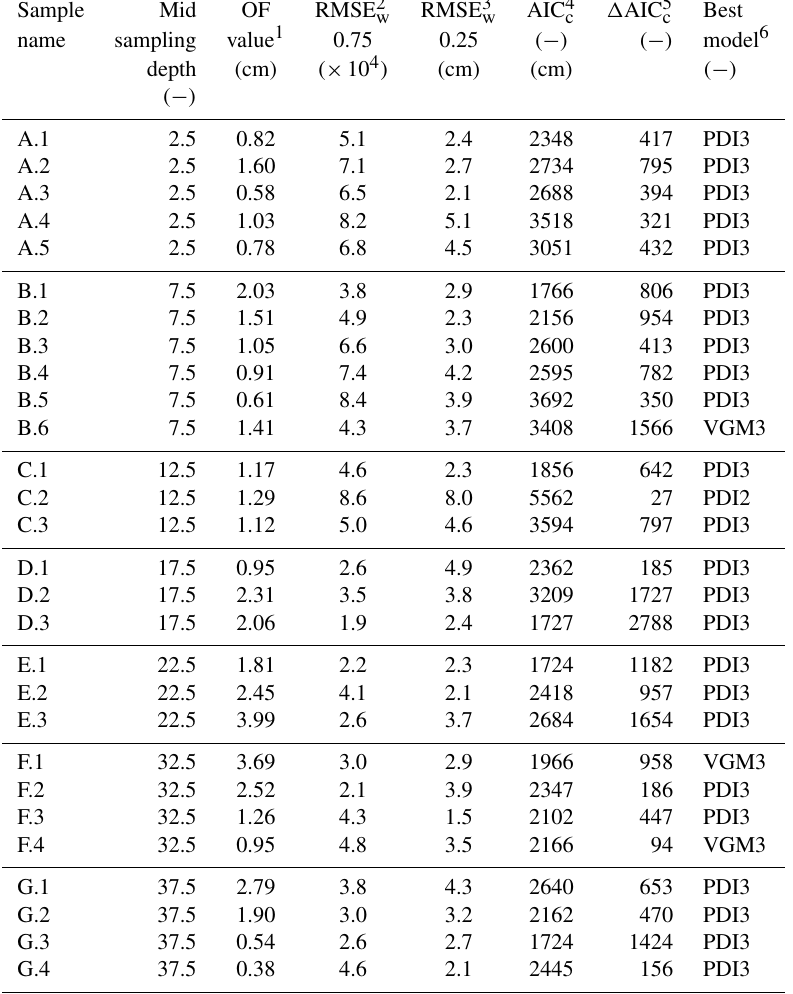
Table 1. Statistical evaluation results of the inverse parameter estimation for 31 samples of eight mid sampling depths.